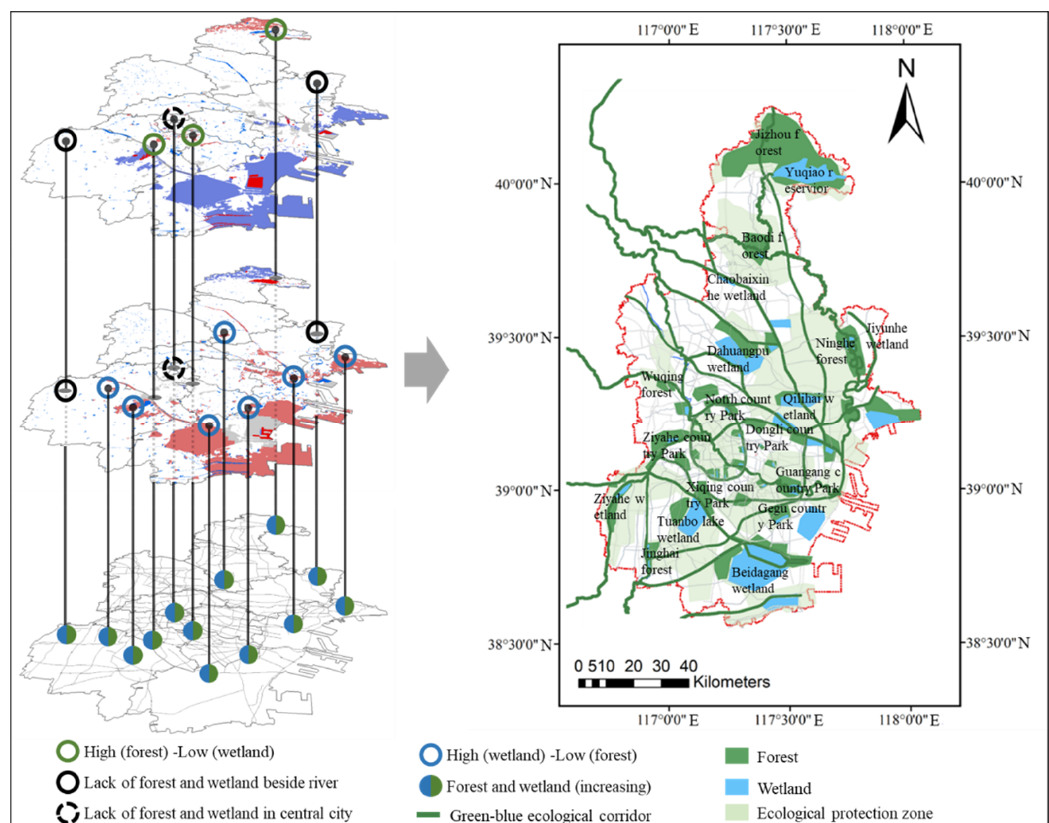
Figure 13. Forest-wetland ecological network in Tianjin.